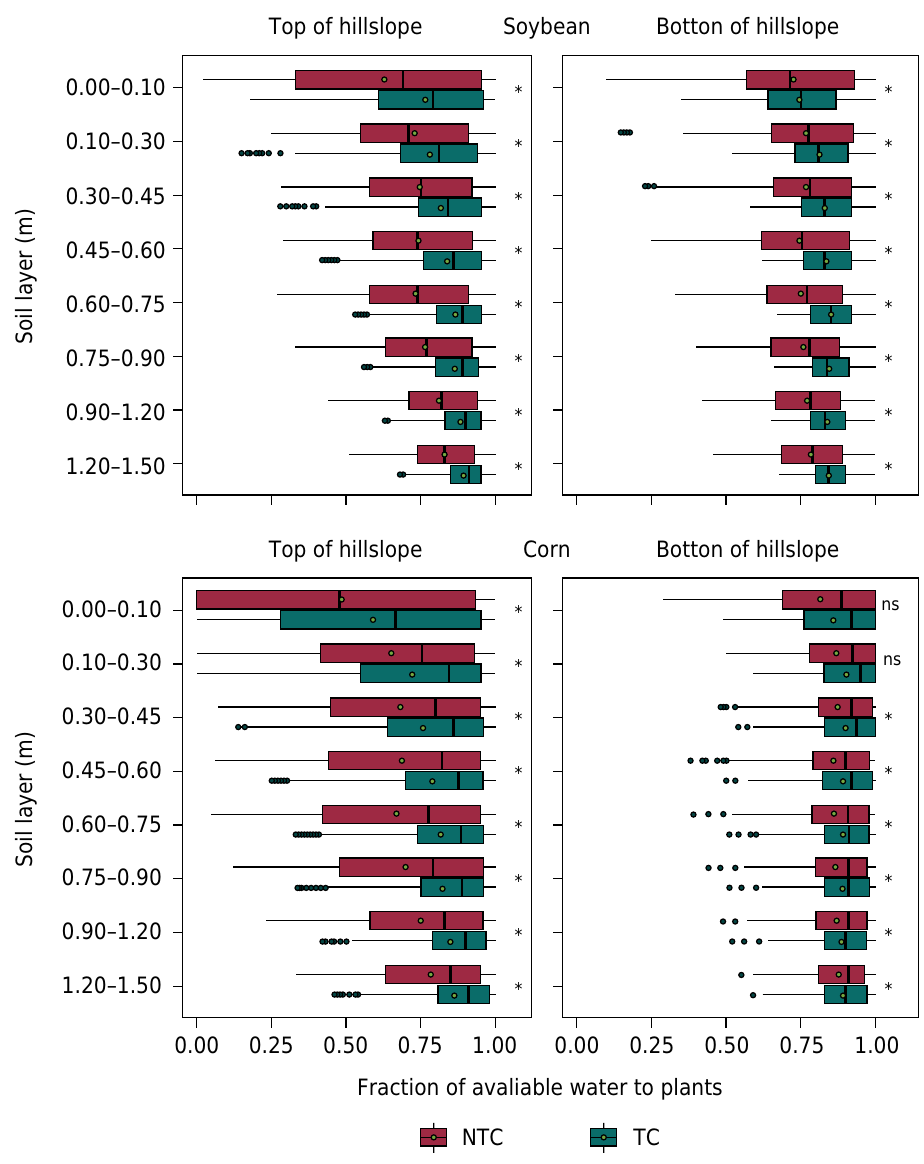
Figure 4. The fraction of available water for plants (FAW) during the corn and soybean cycles in eight layers of the soil profile at the top and bottom position in the non-terraced catchment (NTC) and terraced catchment (TC) in Rio Grande do Sul State, southern